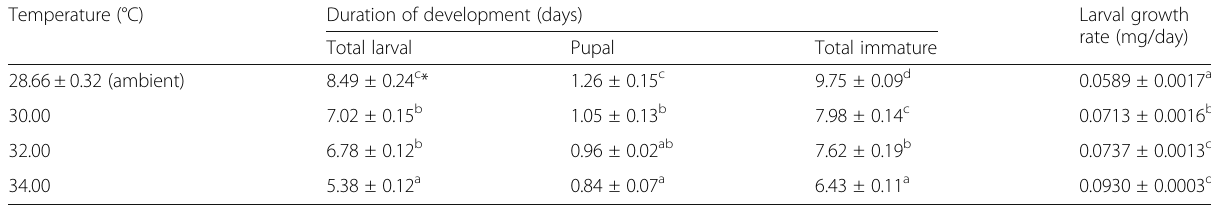
Table 1 Effects of rearing-water temperature on duration of development and larval growth rate of Culex quinquefasciatus mosquito Temperature